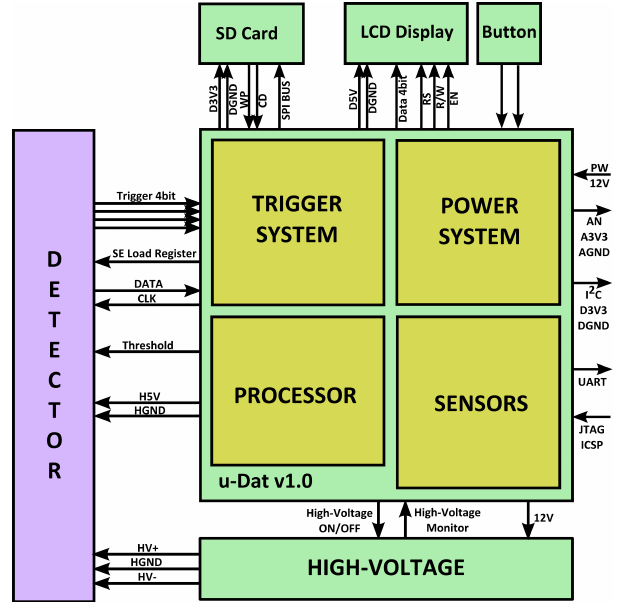
Fig. 2. The schematic plan of the electronics system of the Muon- tomograph G.G.Barnaf¨oldi et al. (2012). flammable mixture of Ar and CO 2 in 80 : 20 proportion. A standard 10 liter bottle (with 150 bar filling pressure) is suf- ficient for 20 days of continuous operation at ∼ 3 L h − 1